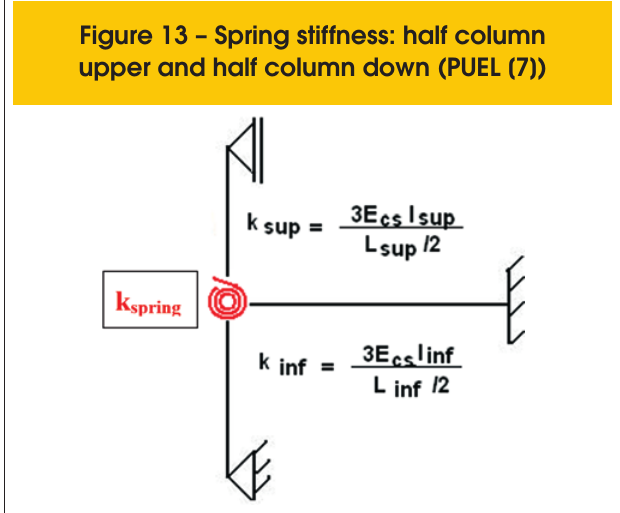
Figure 13 – Spring stiffness: half column upper and half column down (PUEL